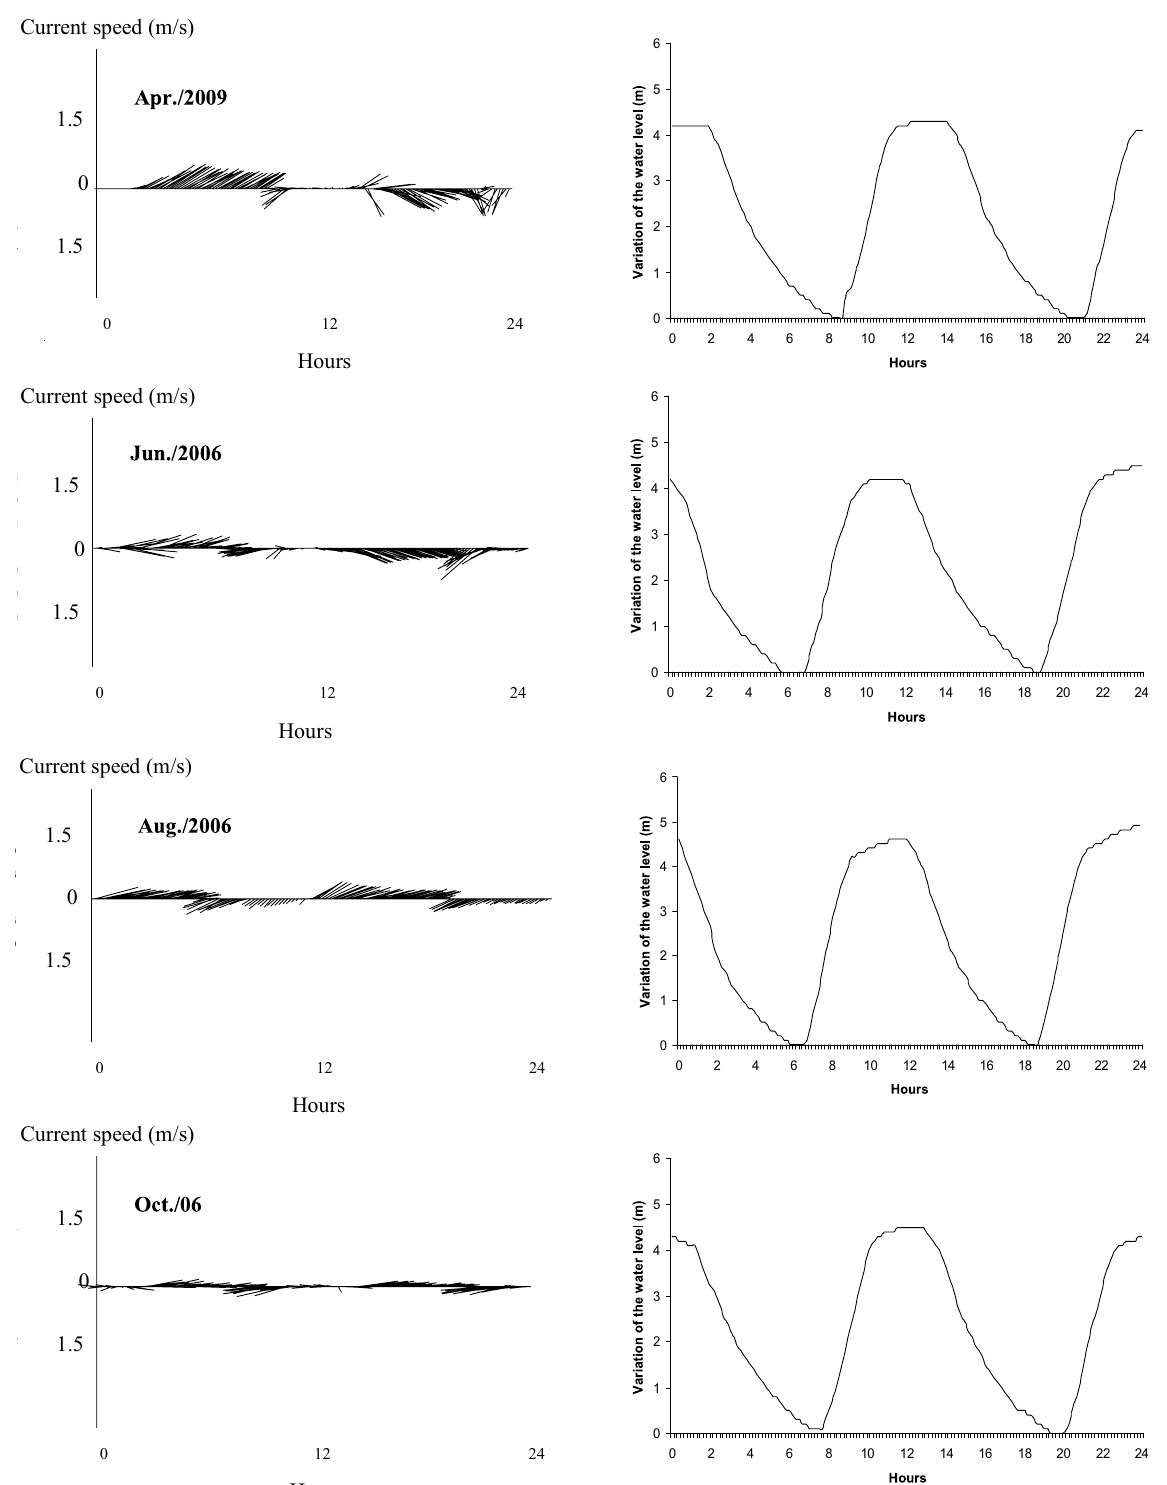
Fig. 2 – Hydrodynamic data recorded between April/06 and February/07, during spring tides, in the Caeté